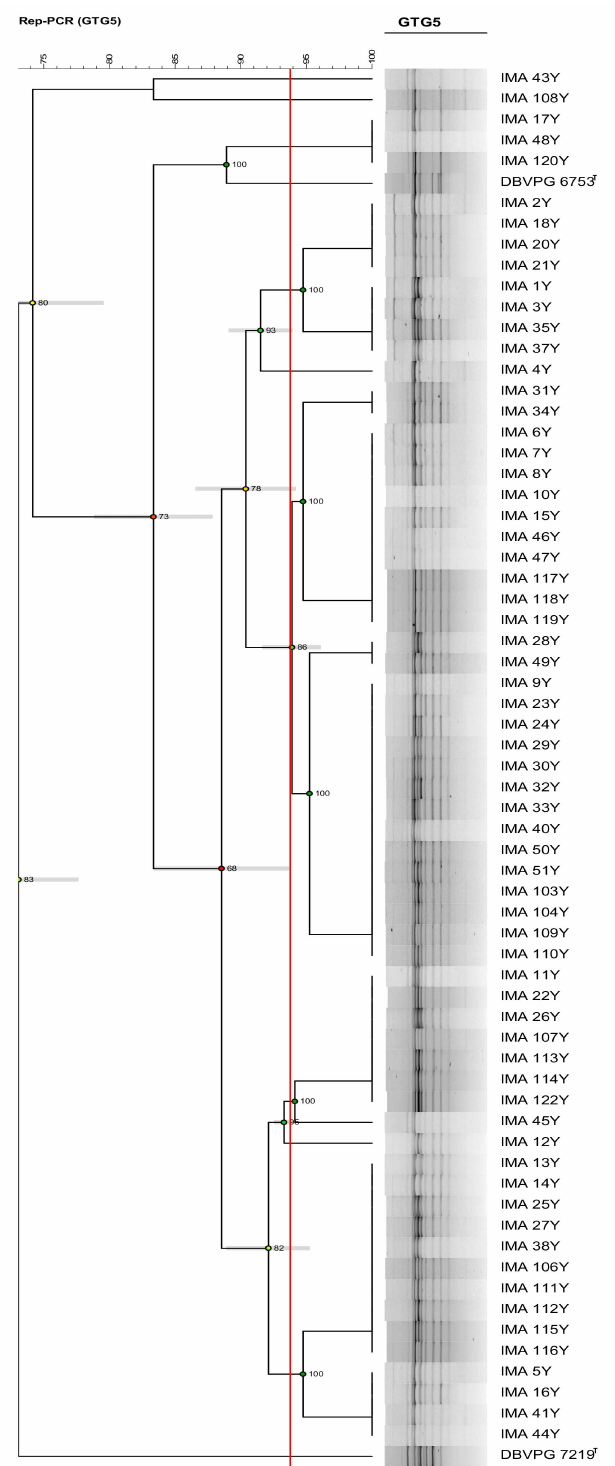
Figure 4. Dendrogram obtained from UPGMA analysis, using Dice’s coe ffi cient, based on (GTG) 5 rep-PCR profiles, of the 65 K. humilis isolates characterizing PDO Tuscan bread sourdough and two reference strains. The red line indicates the similarity value (93.78%) for separation of biotypes. Standard deviation is shown at each node by a grey bar. Cophenetic correlation is shown at each branch by numbers and coloured dots, ranging between green-yellow-orange-red, according to decreasing